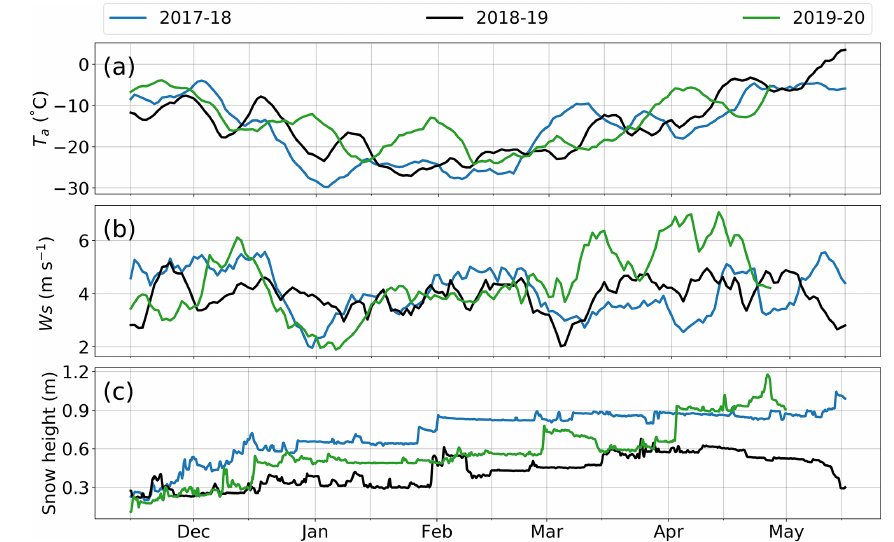
Figure 2. Rolling mean of daily air temperature ( T a ), wind speed (Ws), and snow height for three consecutive winters. Labeled tick marks on the x axis indicate the start of each month.